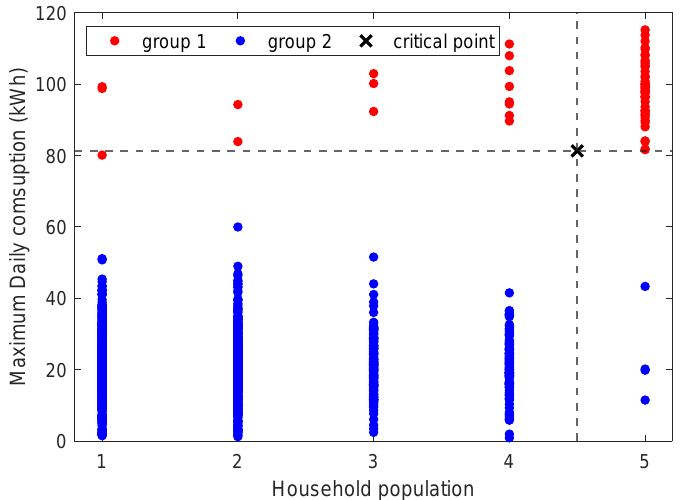
Figure 1. Grouping scheme and critical point in household population-load